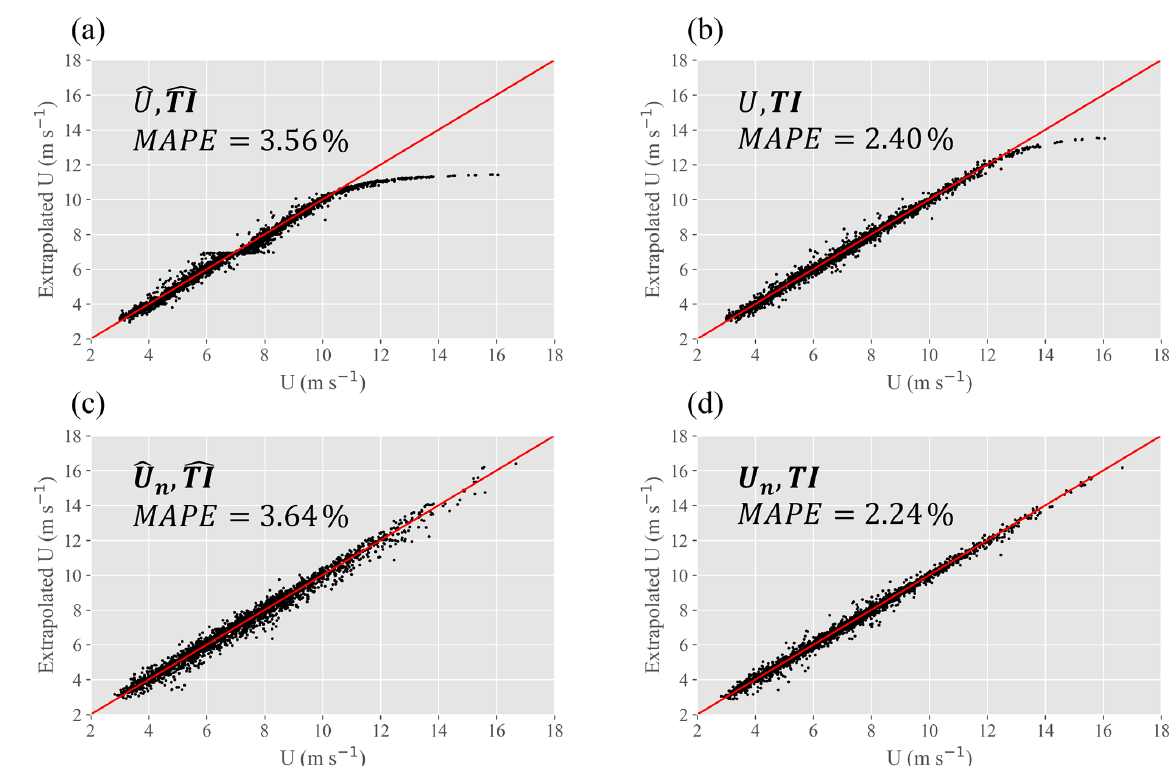
Figure C1. Comparison of test results using standardization and nondimensionalization (for U ) preprocessing techniques. Standardiza- tion (a, c) can be seen to reduce prediction accuracy, whereas transformation of U to U n ( U shown in a and b , U n in c and d ) can be seen to improve predictive accuracy by removing the tailing effect at high wind